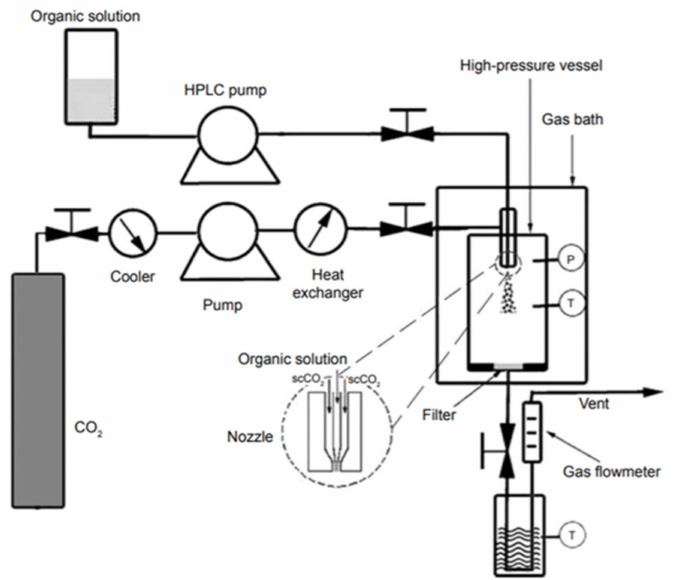
Figure 5. Schematic diagram of SEDS process. Abbreviations: SEDS, solution-enhanced dispersion